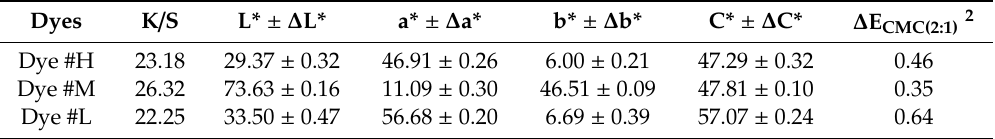
Table 7. Obtained values of color yield (K / S) and colorimetric coordinates 1 (in D65 / 10 ◦ ) of samples dyed with used dyes under optimum dyeing